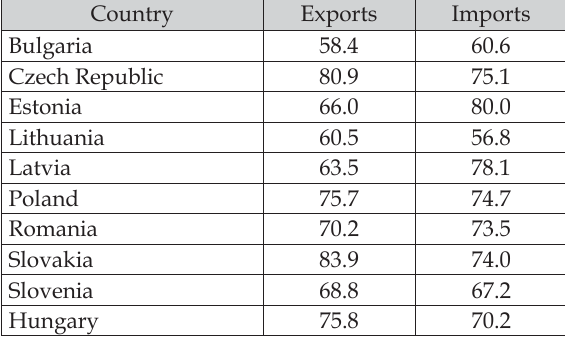
Table 1. Trade of the post-communist countries with the EU as the share of their foreign trade volume in